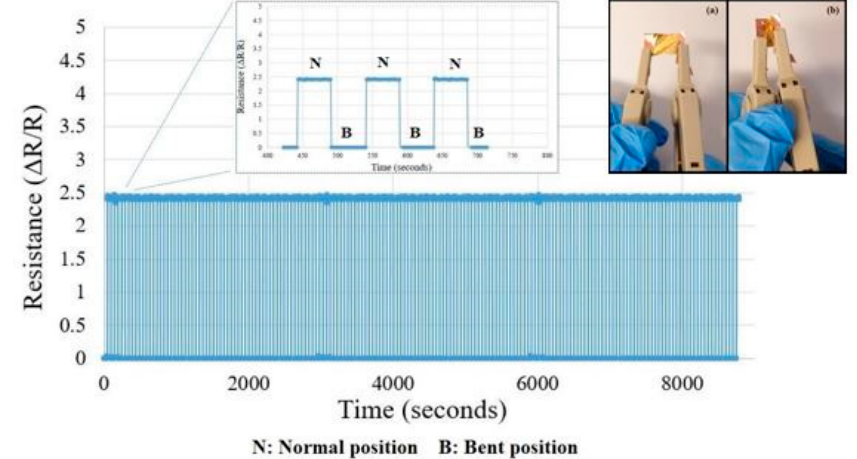
Figure 6. Consecutive bending of the gold-polyimide sensors to determine the repeatability in the changes in their responses. The inset of the figure shows the ( a ) normal and ( b ) bent positions. The resistance of the sensors decreased as the position was changed from normal to